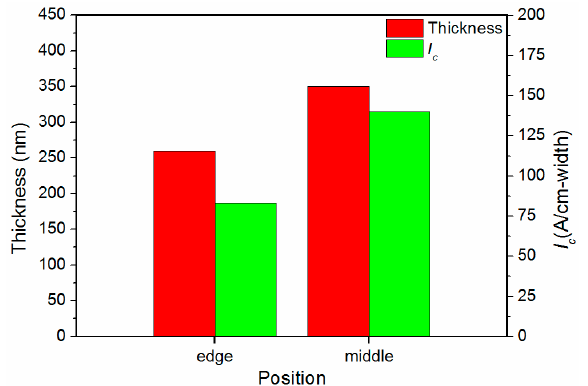
Figure 7. The thickness and I c histograms of the GdYBCO films prepared based on the slit shower.